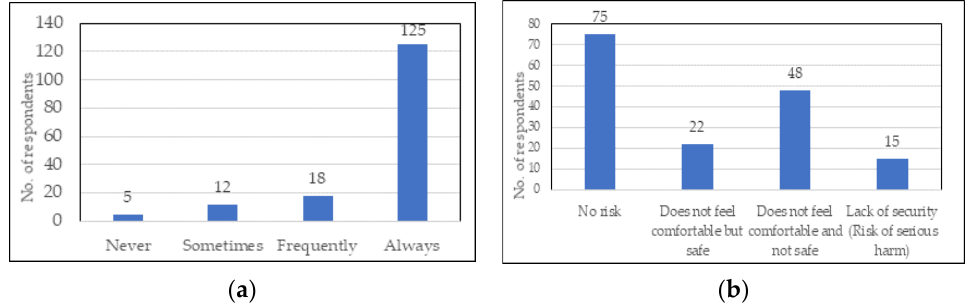
Figure 7. ( a ) Survey responses to the statement that collection of water is mandatory even when women members are sick; ( b ) Reports of security issues during collection of water.